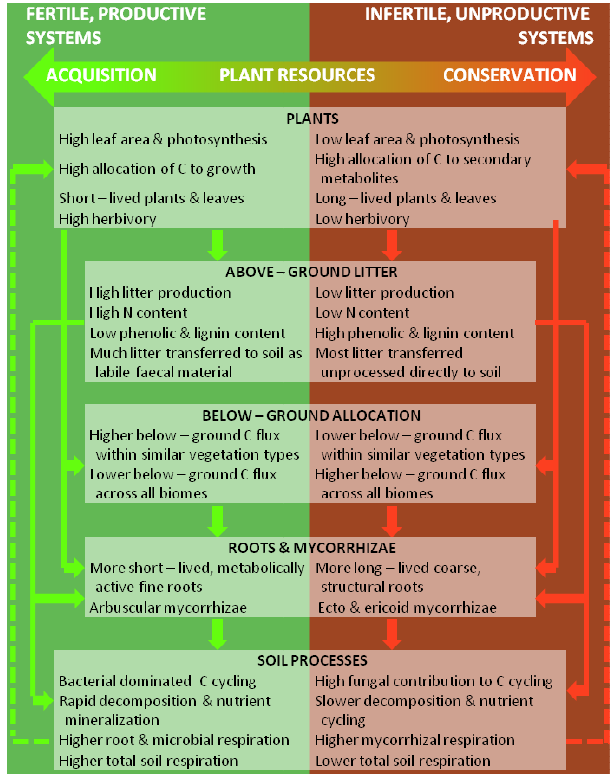
Fig. 1. Conceptual framework of linkages amongst plant traits and key plant and soil processes that affect soil CO 2 efflux in contrast- ing terrestrial ecosystems. Note that these are generalizations with many exceptions. Modified from Wardle et al.